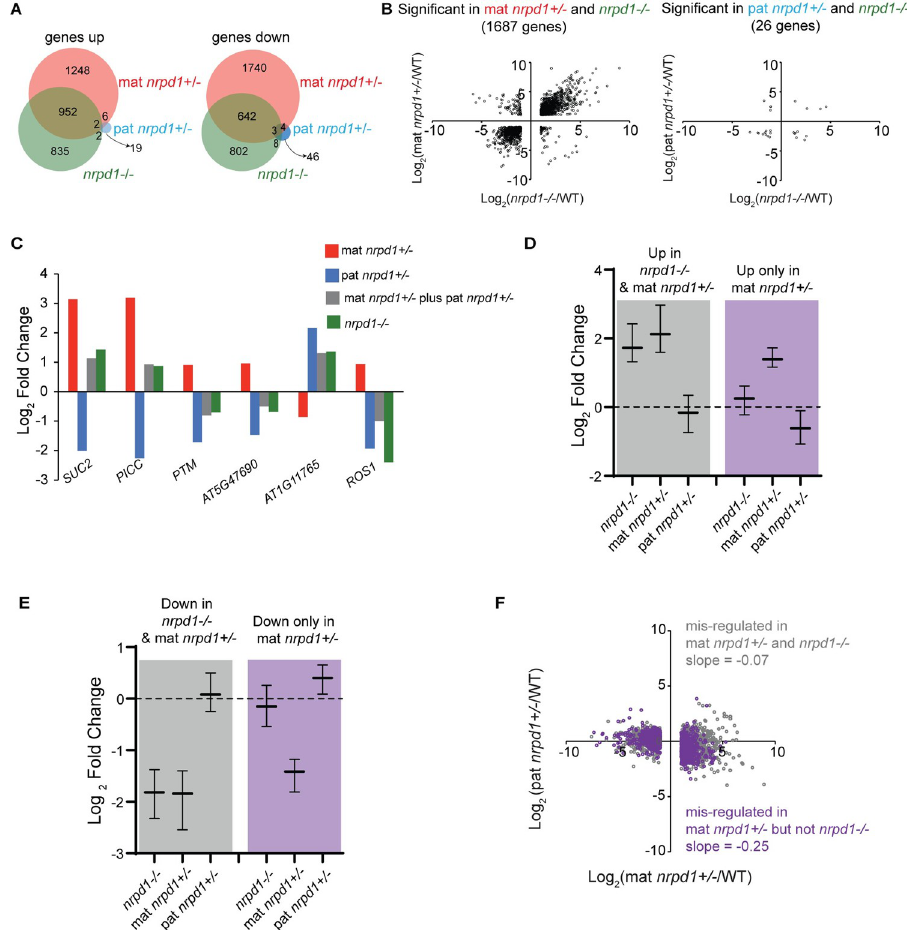
Fig 3. Maternally and paternally acting Pol IV have antagonistic effects on endosperm gene expression. (A) Venn diagrams showing overlap of genes with increased and decreased expression in comparison to WT endosperm for the indicated genotypes. (B) Scatter plots of genes that are significantly different (q � 0.05, Log 2 (Fold Change) � 1 or � − 1) between WT and the indicated mutants. Fold change calculated using Cuffdiff. (C) Examples of genes that are antagonistically regulated by Pol IV. Gray bars represent mathematical sum of effects observed in mat and pat nrpd1 +/− . (D–F) Inverse relationship between changes in gene expression in mat and pat nrpd1+/− relative to WT. Genes that are antagonistically influenced by maternal and paternal NRPD1 are colored purple, while genes not antagonistically regulated are colored gray. In D, genes up-regulated at least 2-fold in both nrpd1− / − and mat nrpd1 +/− do not exhibit misregulation in pat nrpd1+/− , while genes up-regulated only in mat nrpd1+/− but not nrpd1− / − have decreased expression in pat nrpd1+/− . In E, genes down-regulated in both nrpd1− / − and mat nrpd1+/− are not misregulated in pat nrpd1+/− , while genes down-regulated only in mat nrpd1+/− but not in nrpd1− / − are overall slightly increased in expression in pat nrpd1+/− . In F, genes that are significantly (2-fold, q � 0.05) misregulated in both mat nrpd1+/− and nrpd1− / − show little to no inverse relationship between mat and pat nrpd1+/− (slope = − 0.07), while genes that are only misregulated in mat nrpd1+/− but not nrpd1− / − are inversely affected in pat nrpd1+/− (slope = 0.25). Plots D and E show median and interquartile range for log 2 (fold change) in mutant/WT. Fold change were calculated by Cuffdiff. Data represented in this figure can be found in S4 Data. Pol IV, polymerase IV; WT, wild